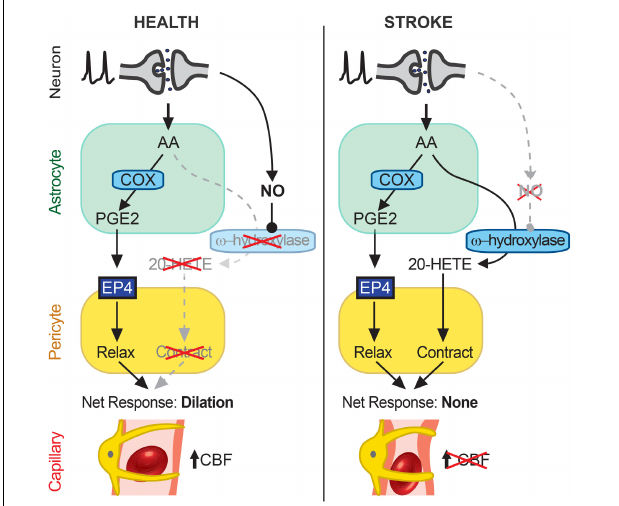
FIGURE 6 | Schematic summary of findings. In healthy cortical tissue (left), neuronal activity stimulates AA synthesis and downstream metabolism to PGE2 in astrocytes. PGE2 acts on EP4 receptors on pericytes to relax them and induce capillary dilation, thus allowing an activity-coupled increase in CBF to occur. 20-HETE synthesis is inhibited by NO, likely synthesized in an activity-dependent manner from neurons (26), which suppresses pericyte contraction. After stroke (right), AA in astrocytes continues to be metabolized to PGE2, which acts on EP4 receptors to relax pericytes, but the reduction in NO generation disinhibits a parallel AA metabolism pathway via CYP450 ω -hydroxylases to produce 20-HETE, which causes pericyte contraction. The cell type(s) in which CYP450 ω -hydroxylases are active remain unknown but may include both astrocytes and pericytes. The opposing effects of EP4-dependent relaxation and 20-HETE-induced contraction of pericytes result in no net change in capillary diameter and therefore no increase in CBF. Over time, this reduced neurovascular coupling could chronically impair resting CBF and contribute to cognitive